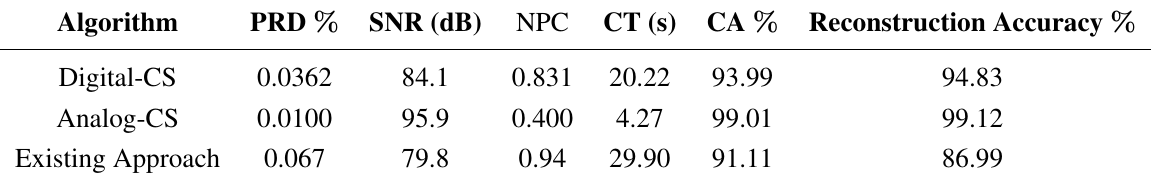
Table 11. Comparison on neuropathy sEMG signals.